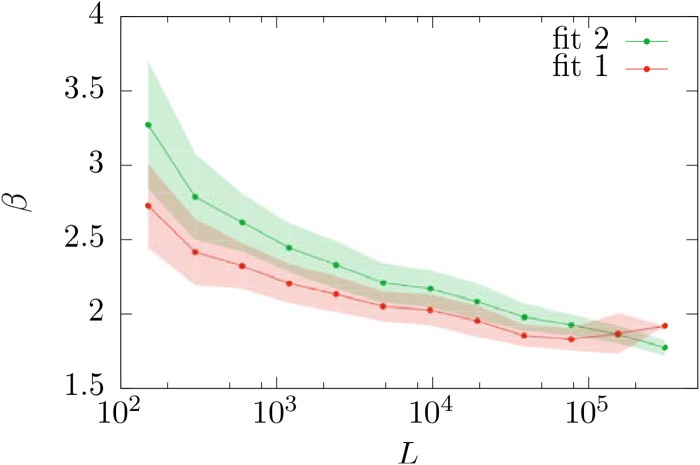
Mean value and standard deviation (represented by the shaded regions) of the distribution of the Zipf’s exponent β as a function of text length L for distributions f1 and f2.Note that the last bin of f1 contains a single datapoint, and so its standard deviation is not defined.